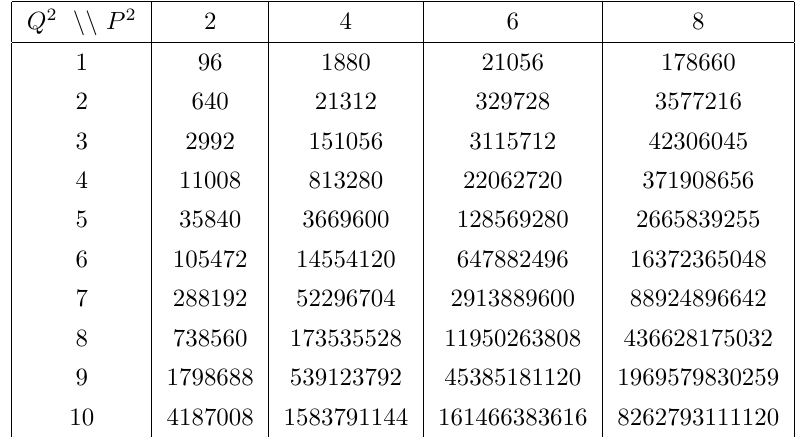
Table 21 . Index of horizon states for the Z 2 orbifold of T 6 for Q · P = 2 .